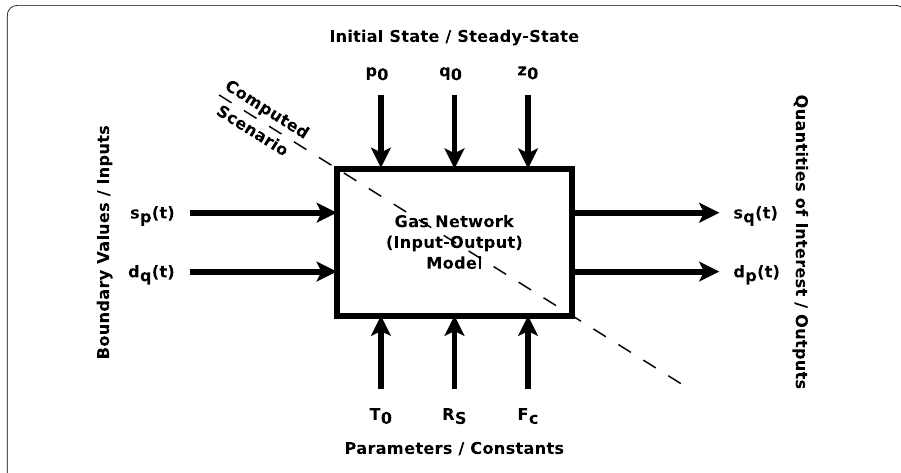
Figure 1 Schematic illustration of gas network input-output